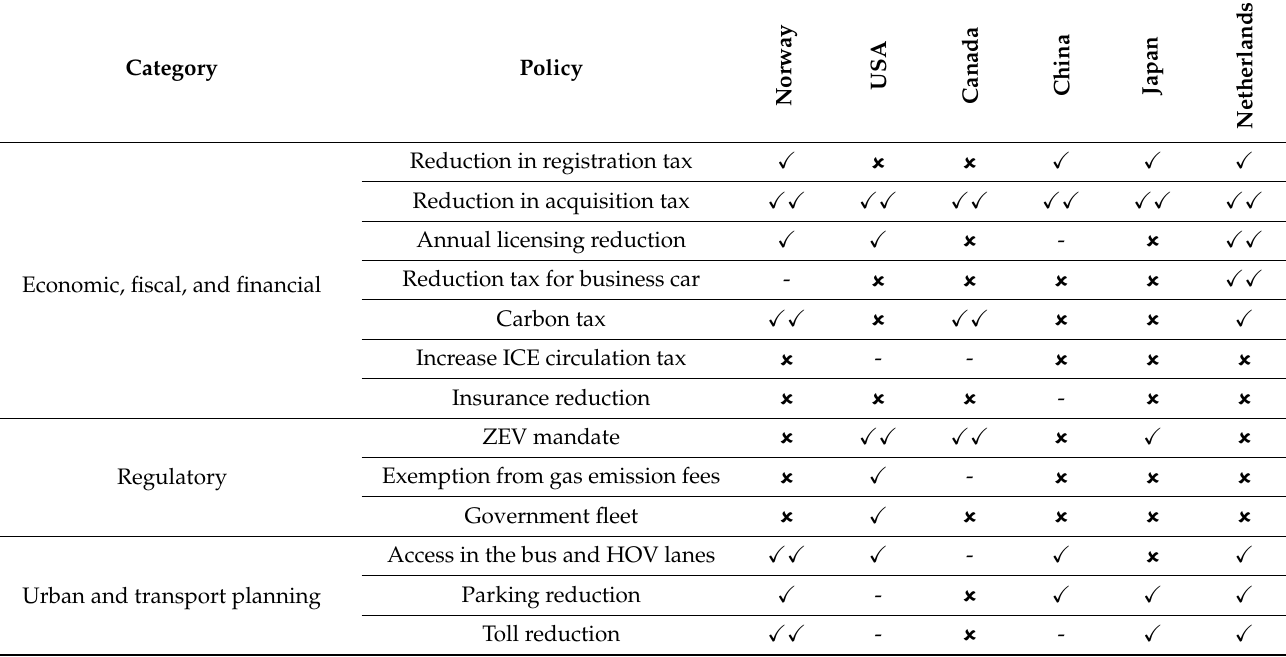
Table 1. EV policies in selected countries.